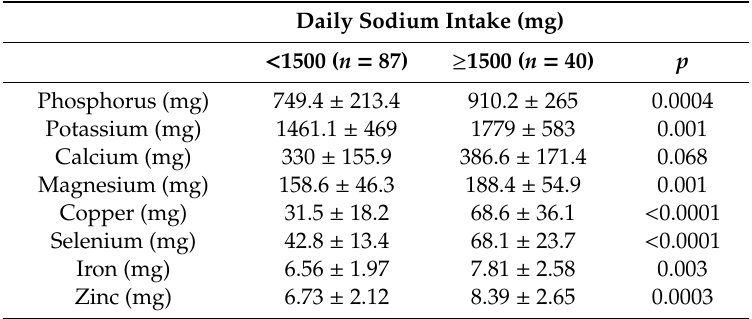
Table 3. Daily dietary intake (mean ± SD) of minerals and trace elements according to the daily sodium intake.